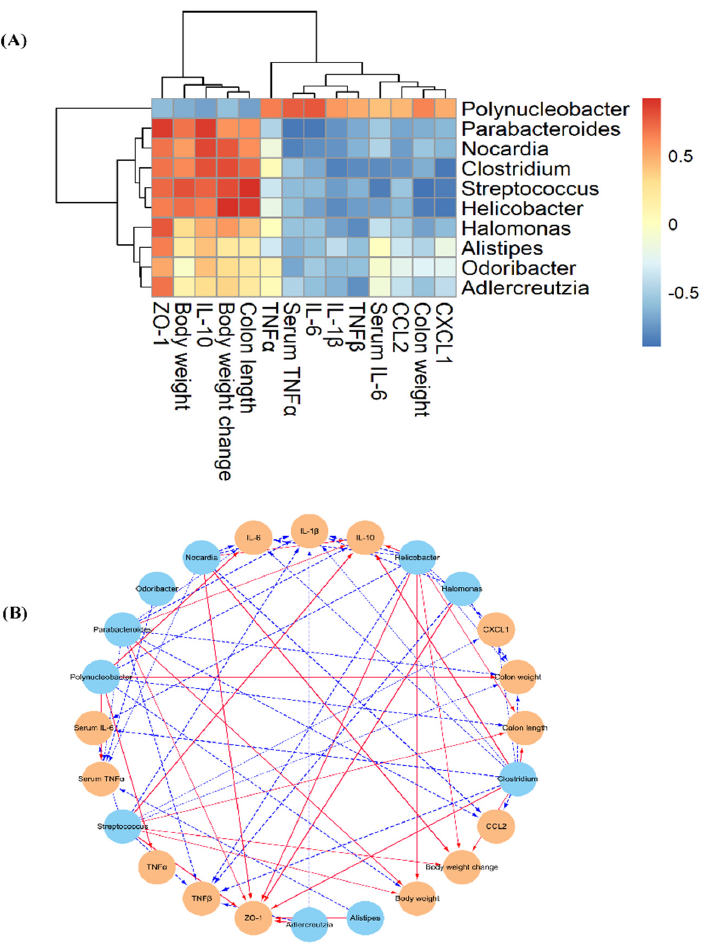
Figure 6. Spearman’s correlation between gut flora abundance and the improvement in colitis. ( A ) Heat map of Spearman’s correlation; ( B ) visualization of the correlation network. Note: the significant edges were drawn in the network using the Spearman correlation test (|r| > 0.6, FDR adjusted p < 0.05).